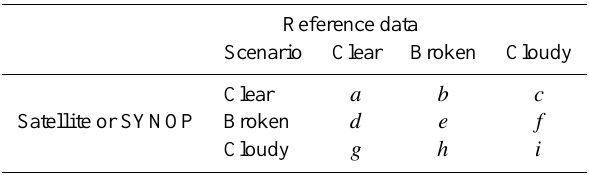
Table 1. Contingency table as shown in Reuter et al. (2009). Cloud- free (clear) is defined as 0–2 oktas, cloud-contaminated (broken) as 3–5 oktas and cloud-covered (cloudy) stands for cloud coverage between 6–8 oktas.